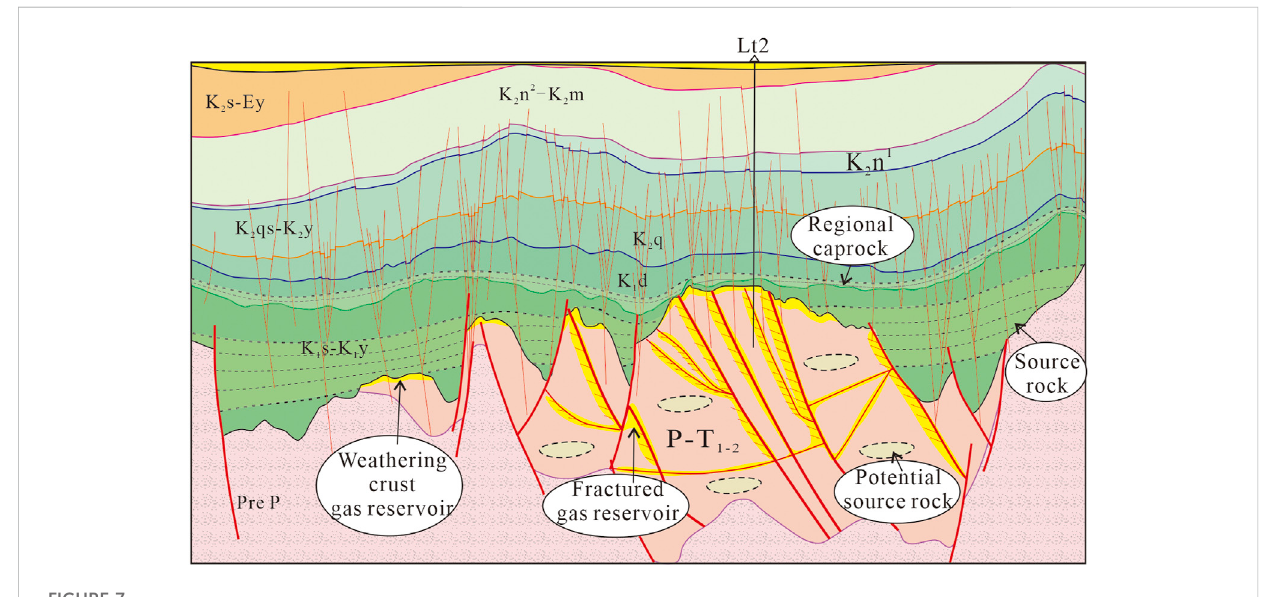
FIGURE 7 Natural gas accumulation model